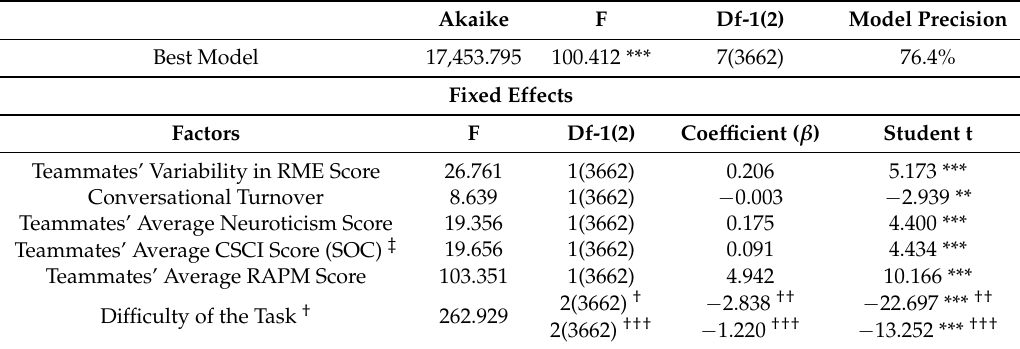
Table 1. Generalized Linear Mixed Model. Effect of groups, members, and tasks characteristics on collective